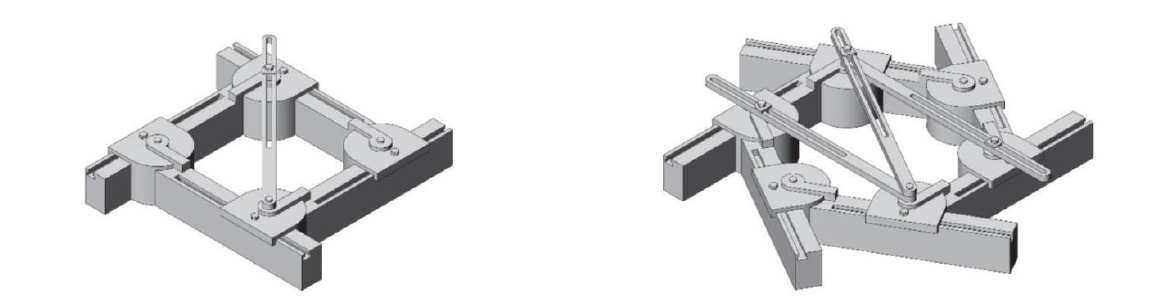
Fig. 15 Diagonals are placed in polygon moulds in order to increase the precision of the resulting